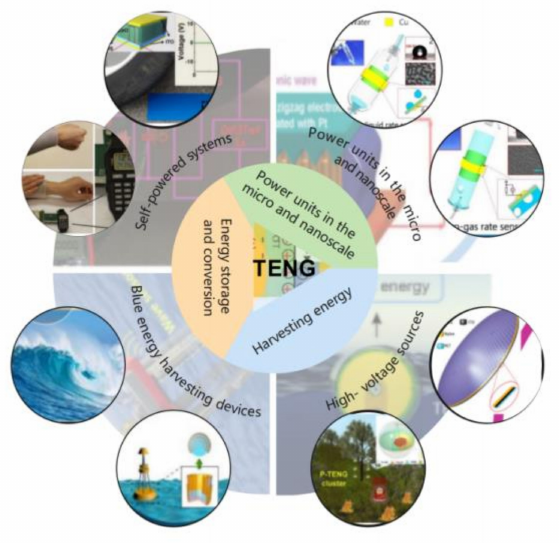
Figure 1. Schematic illustration of the application of